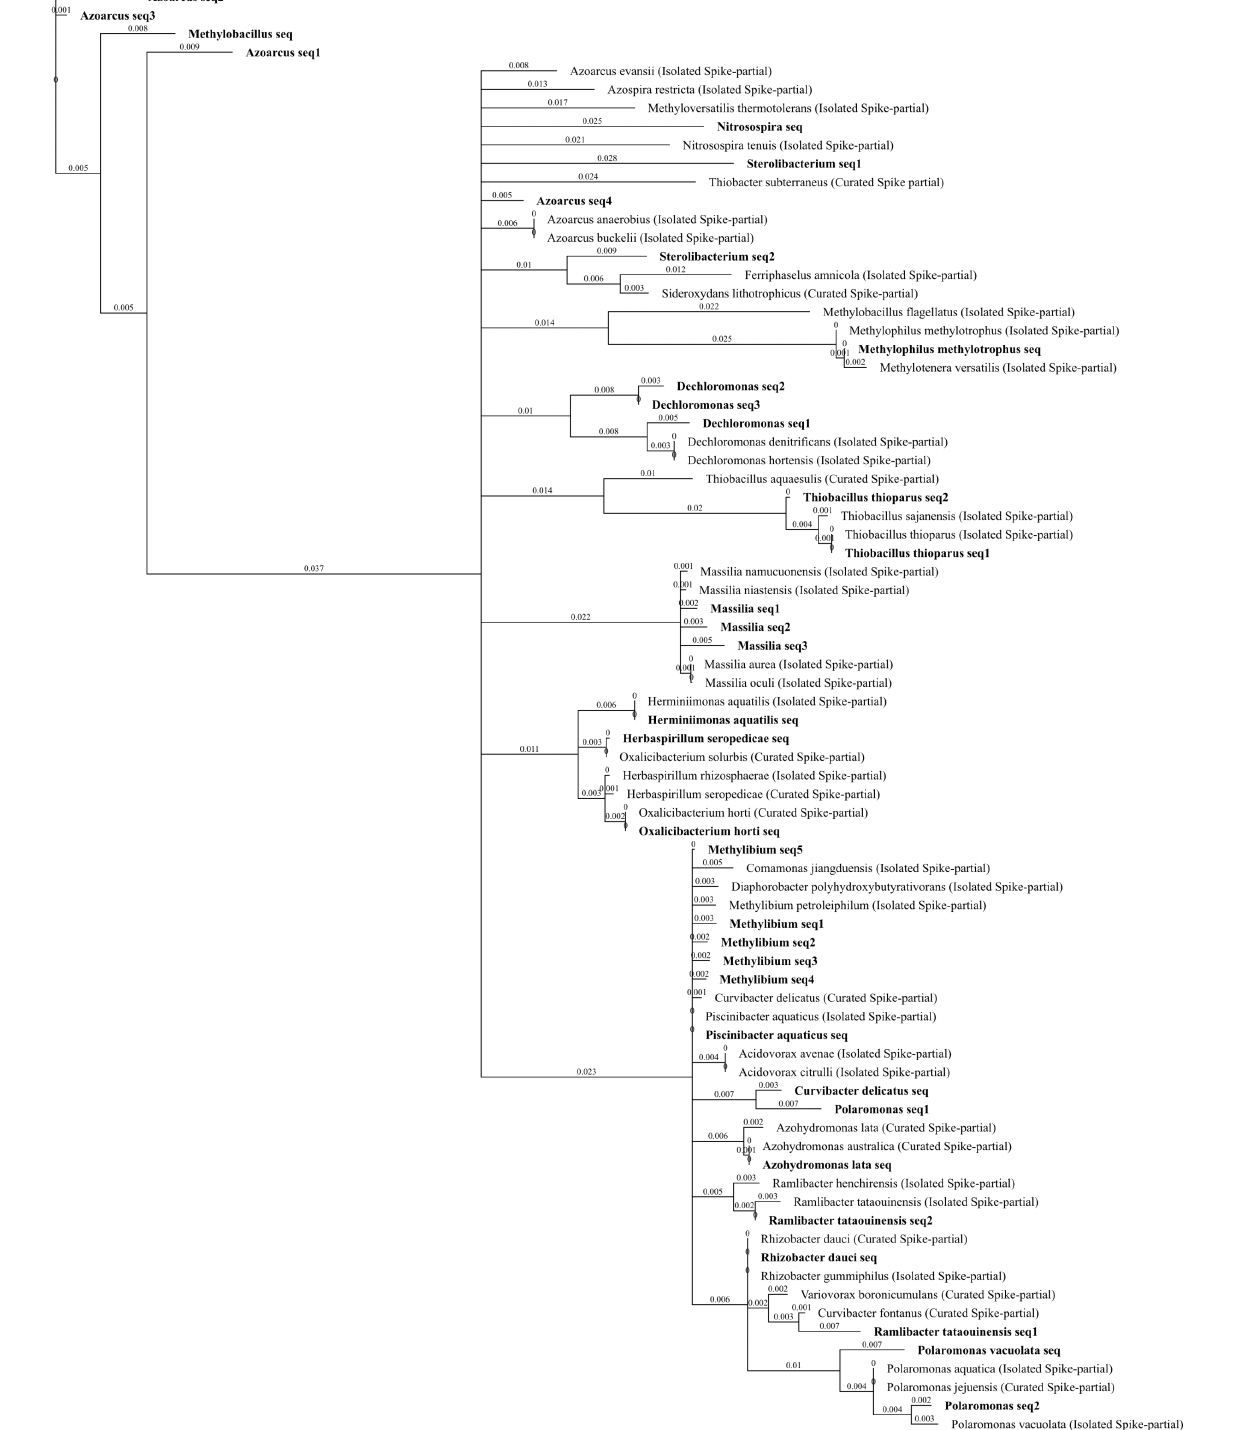
Frontiers in Microbiology |